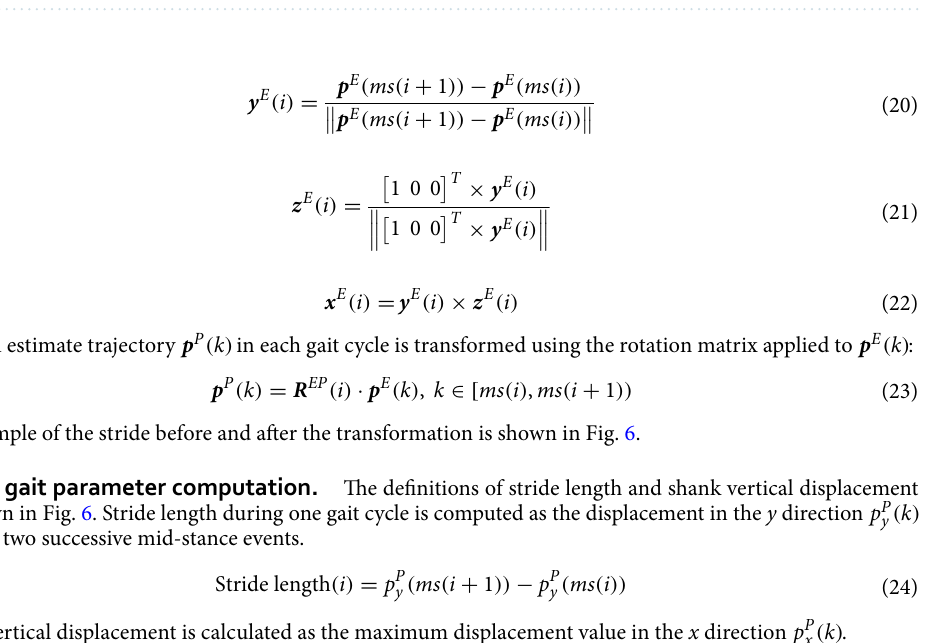
Figure 6. Typical ankle trajectory before (in frame E ) and after transformation (in frame P ). This transformation allows visualising the trajectory and computing the spatial gait parameters. Stride length is defined as the displacement in the anterior-posterior direction; shank vertical displacement is defined as the maximum displacement in the superior-inferior